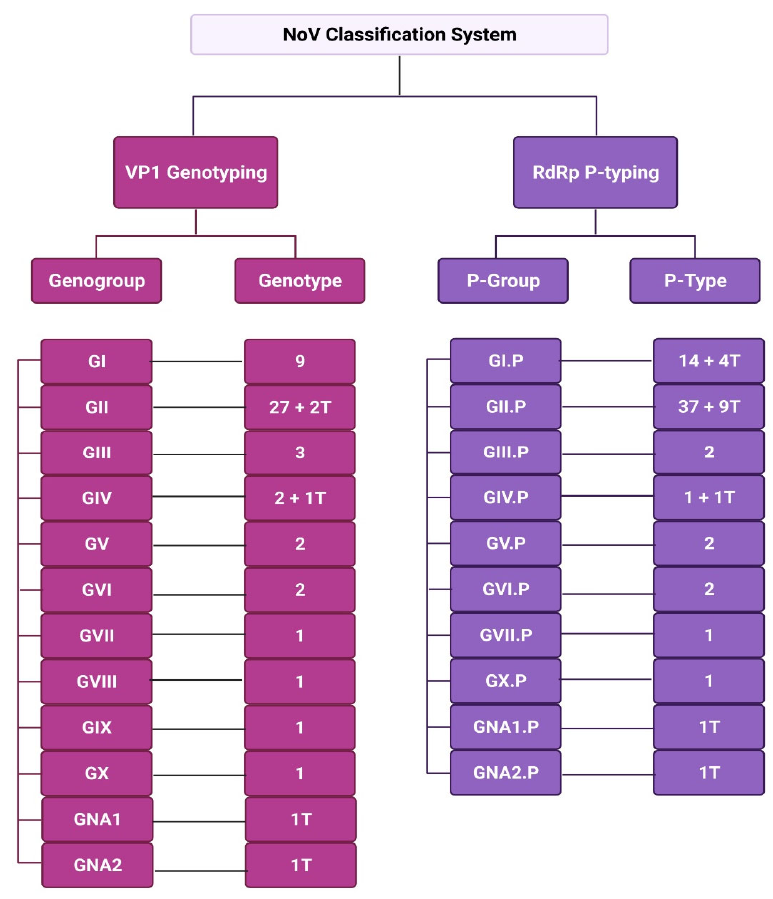
Figure 8. NoV Classification. NoV variants are classified on the basis of whole amino acid sequencing of VP1 capsid protein for assignment into genogroups and genotypes, while partial RdRp sequencing is used for assignment into P-groups and P-types. Currently there are 10 genogroups. Image generated using Biorender.com accessed on 18 October 2022.